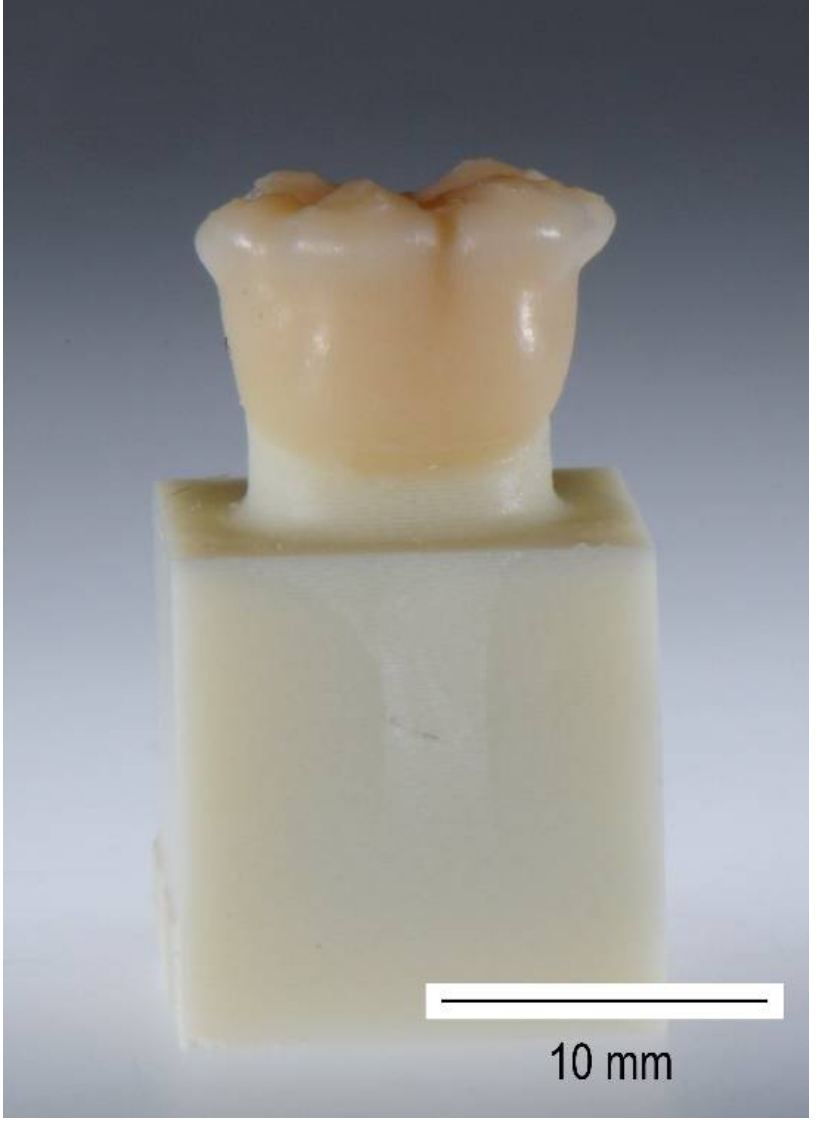
Figure 4. Exemplary manufactured specimen of VA1_nt.